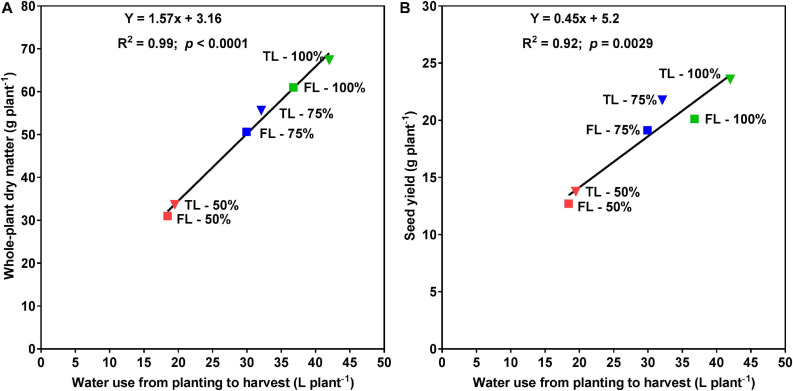
Relationships between whole-plant water use and whole-plant dry matter (A; left), or seed yield (B; right) for soybean grown in 1-m rooting columns in a greenhouse. Fertilizer placement treatments are top loading (TL; triangular symbols) or full loading (FL; square symbols), watered daily to either 100% soil water holding capacity (SWHC; control; green), 75% SWHC (mild drought stress; blue), or 50% SWHC (drought stress; red). The line is the best fit regression, not forced through the origin. Data represent the fertilizer placement by drought stress treatment interaction least square mean values. Five replicates were used.